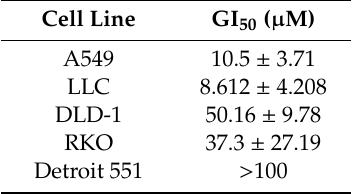
Table 1. GI 50 values of the effect of 24-h IQ treatment on cell viability.